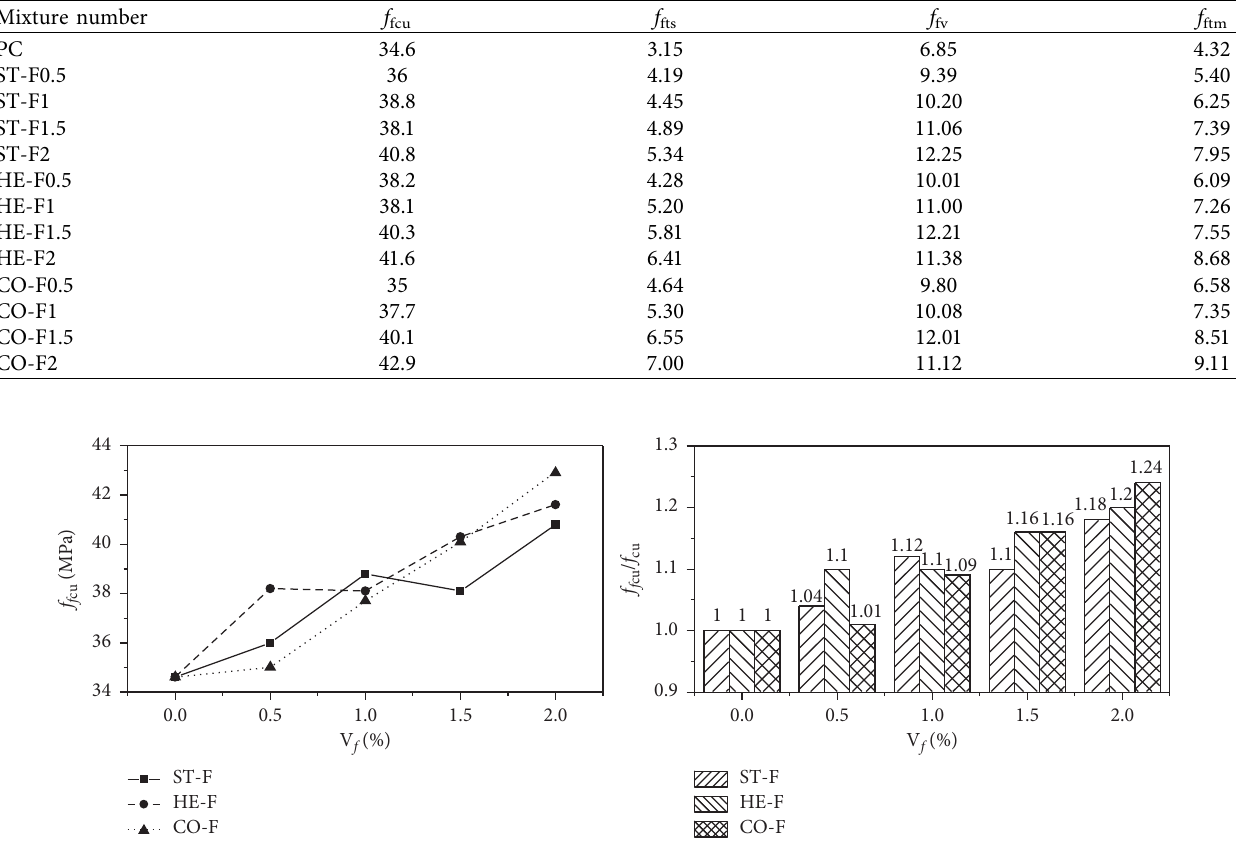
fcu , f fcu / f cu , and V f